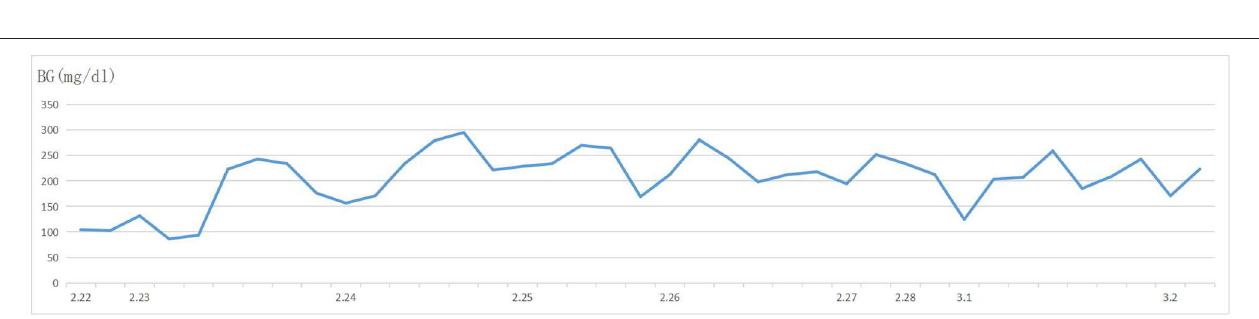
FIGURE 1 | Results of contrast-enhanced abdominal CT before the first surgery. Contrast-enhanced abdominal CT in the (A,B) arterial phase and in the (C,D) venous phase showing an enhanced mass on the tail of the pancreas invading the splenic vessel.